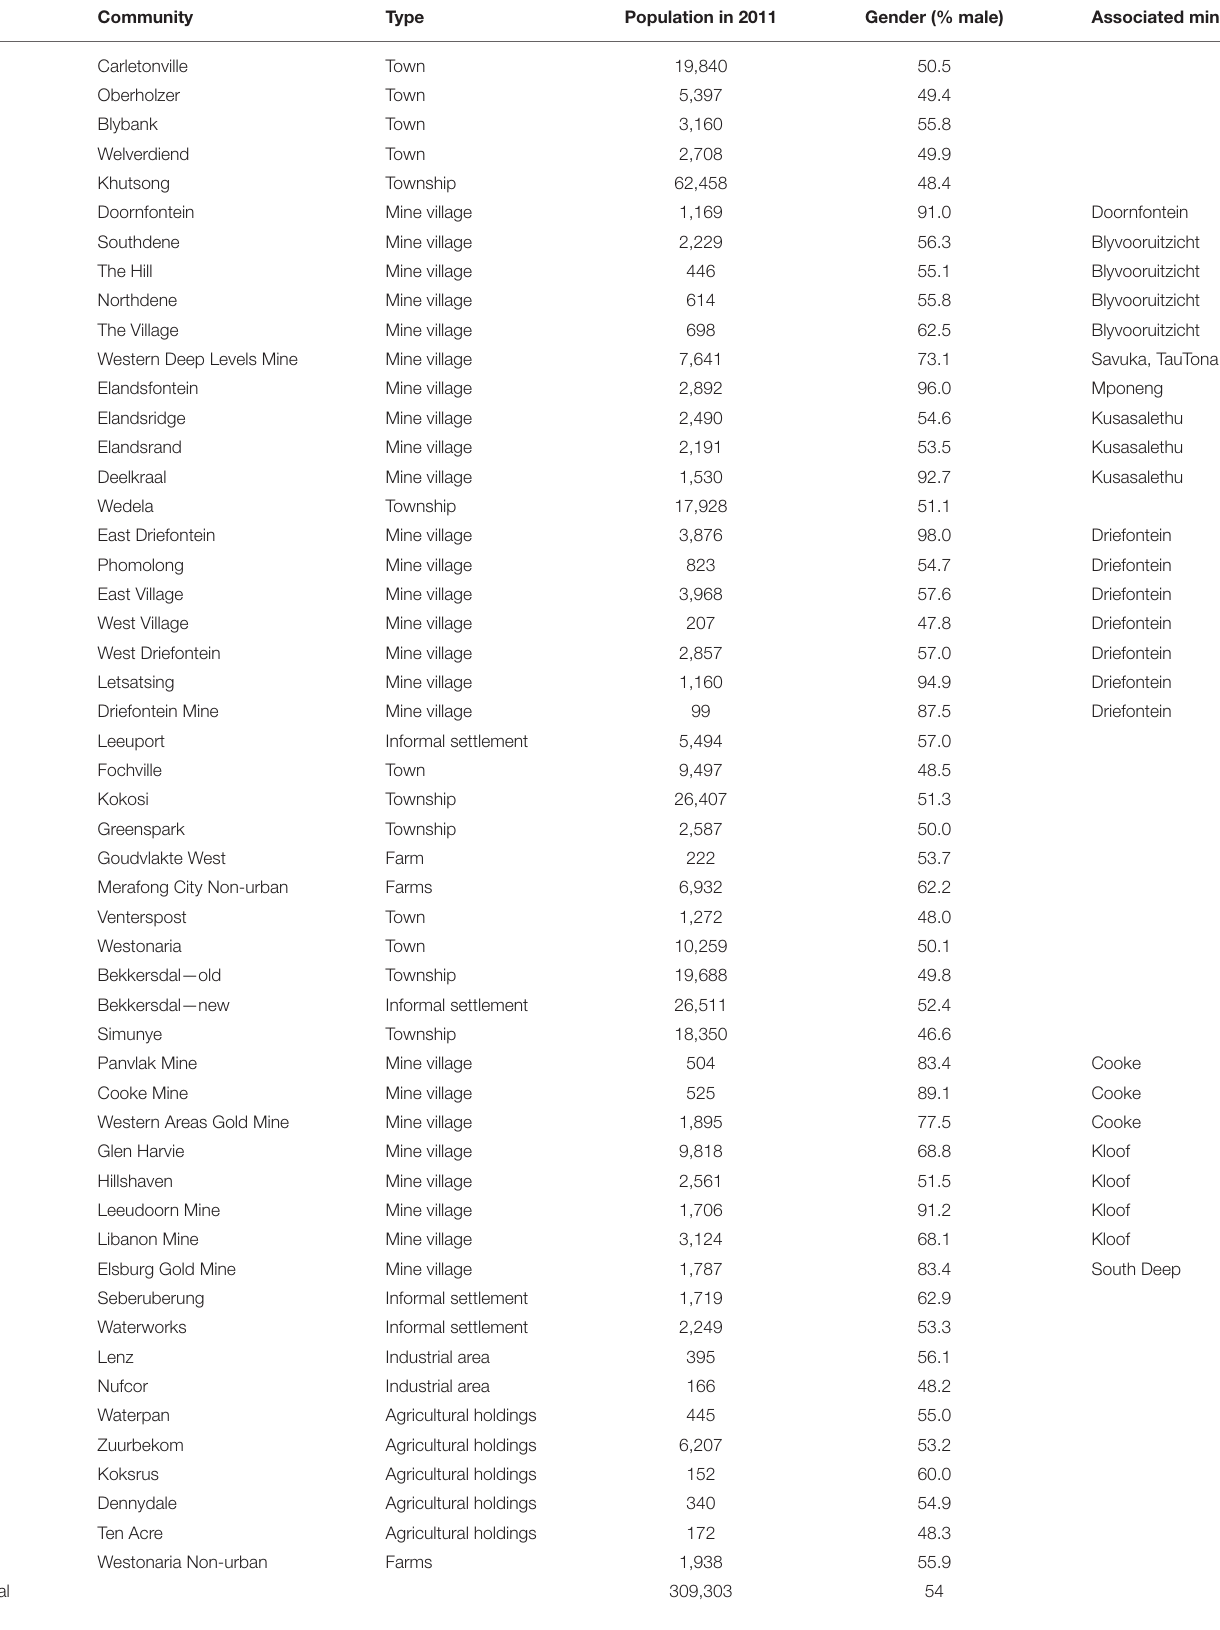
TABLE 2 | Communities in the Far West Rand according to Census 2011 (data source: StatsSA, 2015).